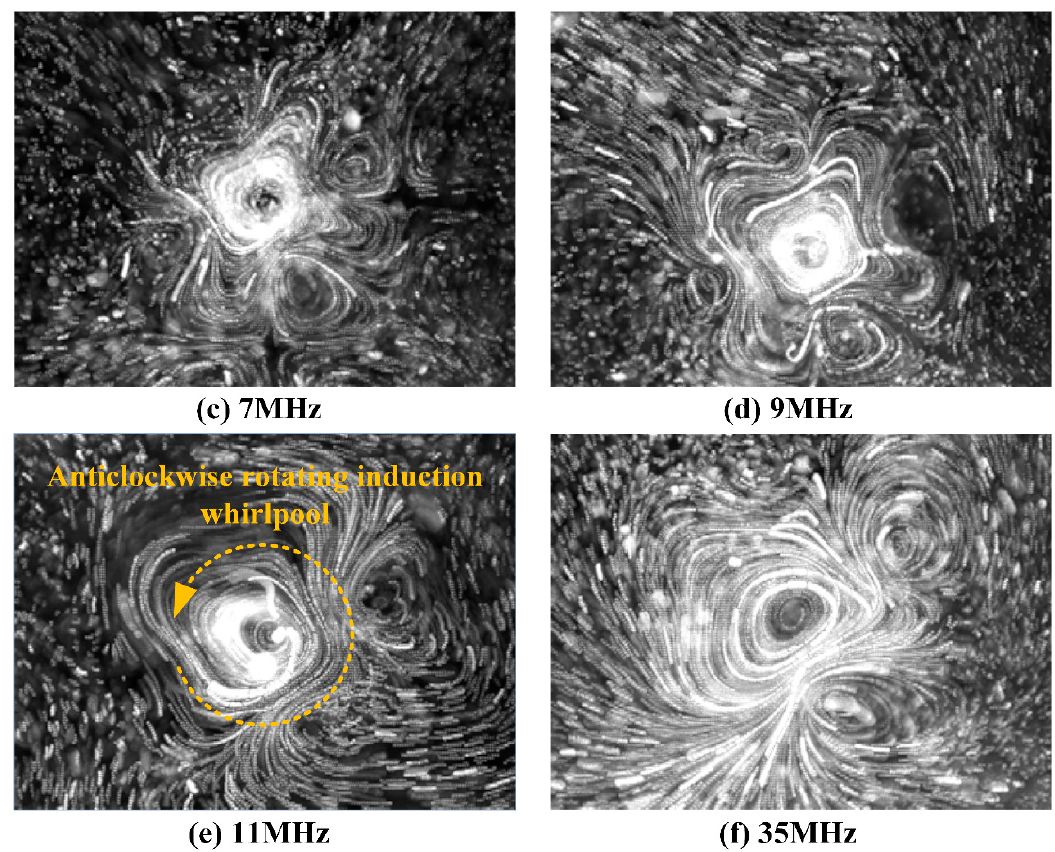
Figure 2. Frequency-dependent flow field of ROT-ETF captured in experiment using a high-speed CCD camera, for given voltage amplitude A = 7.5 V. ( a ) f = 1 MHz; ( b ) f = 3 MHz; ( c ) f = 7 MHz; ( d ) f = 9 MHz; ( e ) f = 11 MHz (relaxation frequency of the dielectric dispersion); ( f ) f = 35 MHz. With increasing field frequency beyond the reciprocal charge relaxation time, rotating streamlines of the anticlockwise induction whirlpool become more circular and less helically cascading downward.